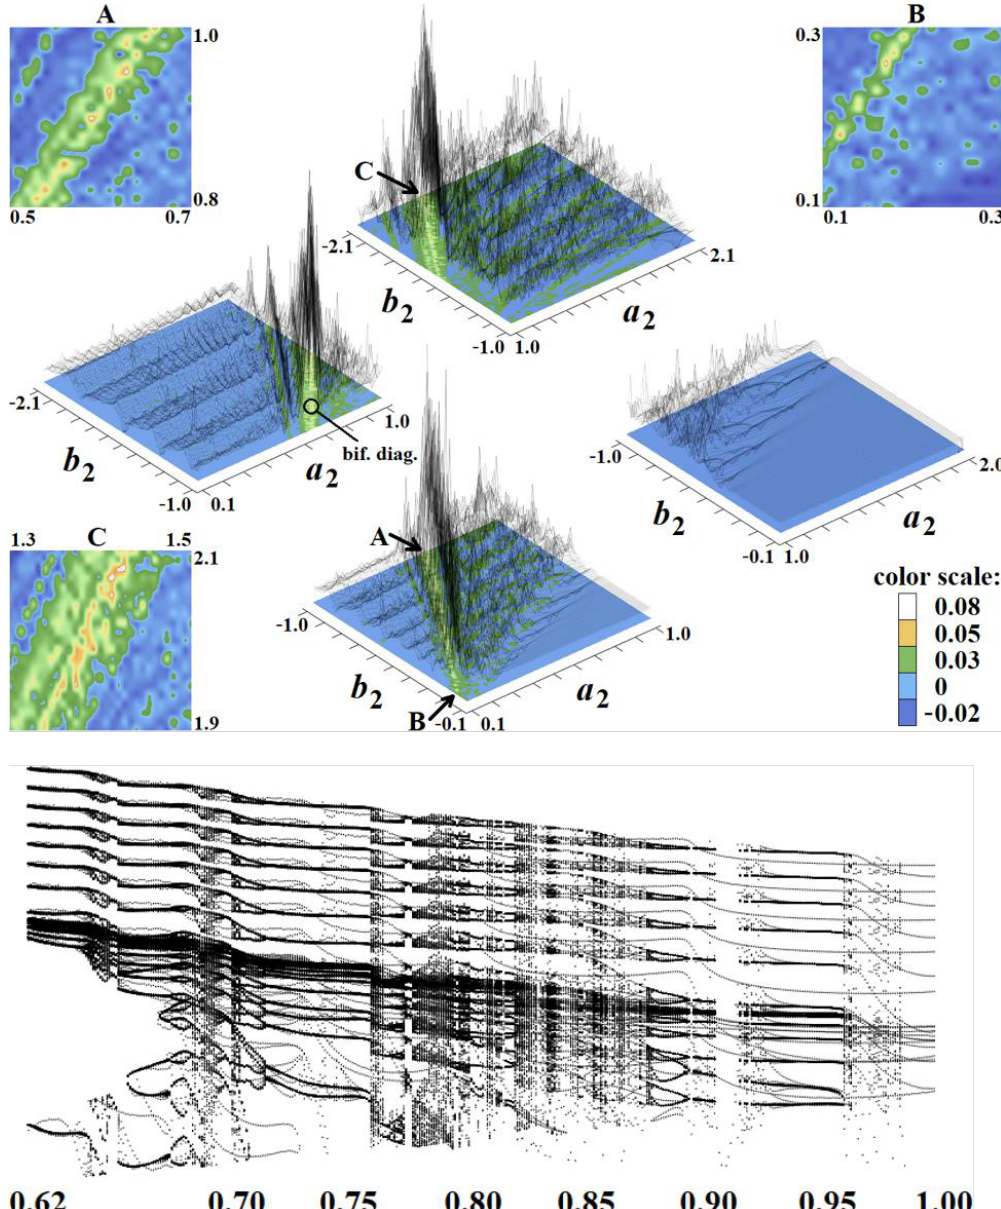
Figure 5. Topographically scaled surface-contour plot of LLE as a two-dimensional function of cubic terms associated with nonlinear transconductances y 12 ( v 2 ) and y 21 ( v 1 ). Bifurcation diagram fitted to the trumpet attractors; cross section chosen as v 2 = − 1.5 V, while state variable v 1 is